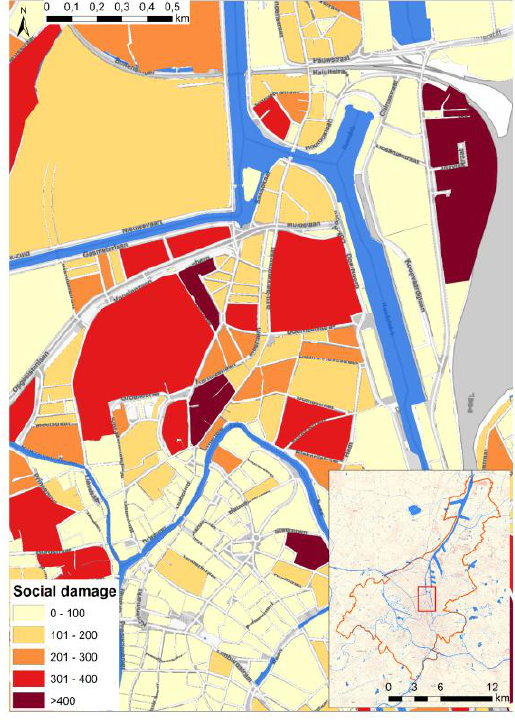
Figure 20. Loss of independence of vulnerable groups resulting from pluvial floods in Ghent.